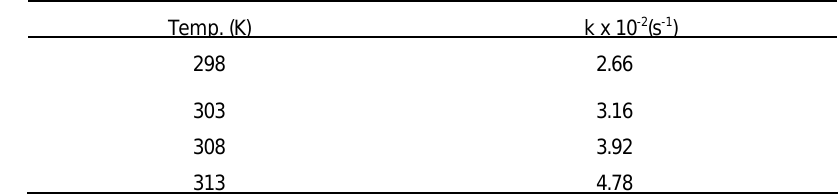
Table 2.Table 2. Thermodynamic activation parameters for the oxidation of diperiodatocuprate(III) by L-proline in alkaline medium with respect to the slow step of Scheme 1Scheme